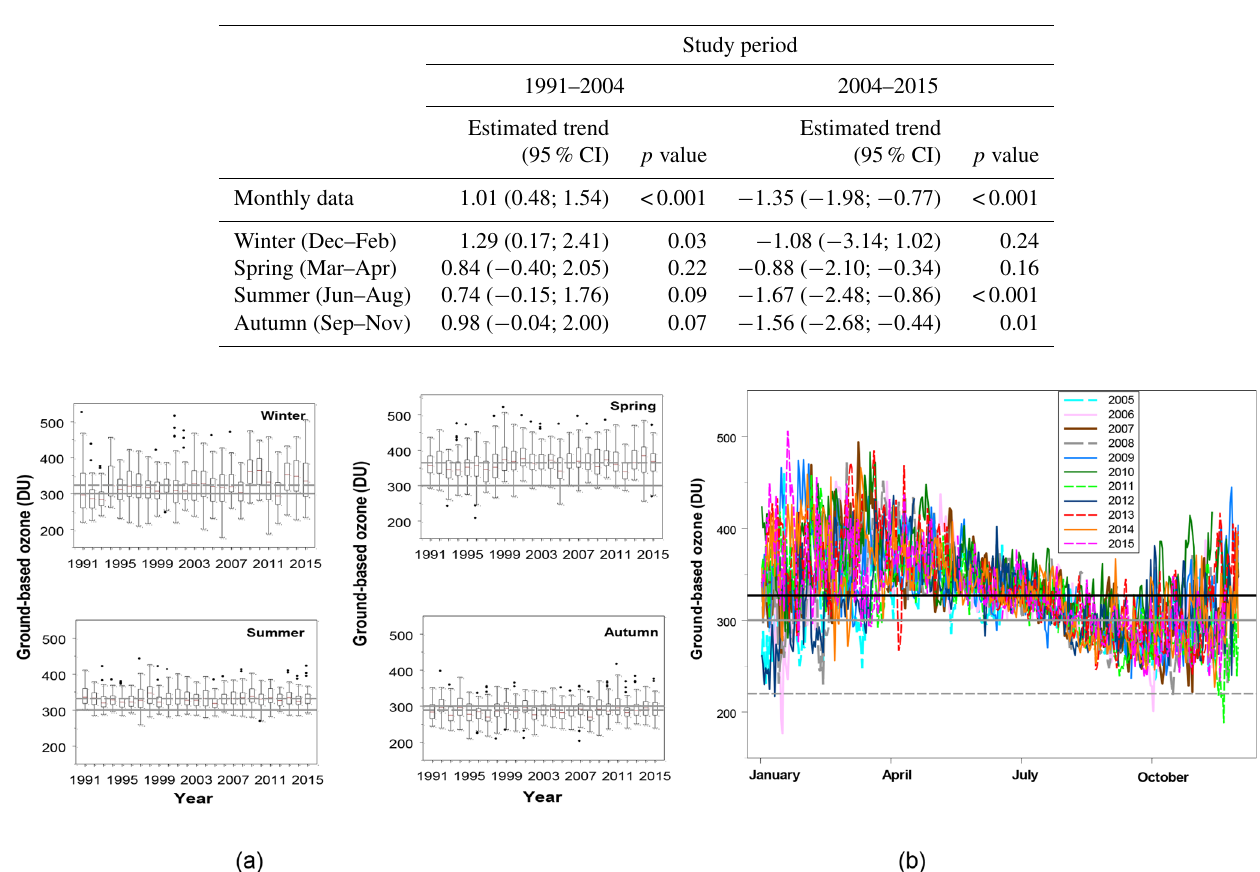
Figure 3. Daily TO values: (a) box plots for each season for the period (1991–2015) in southern England and (b) line plots for the period 2005–2015 at